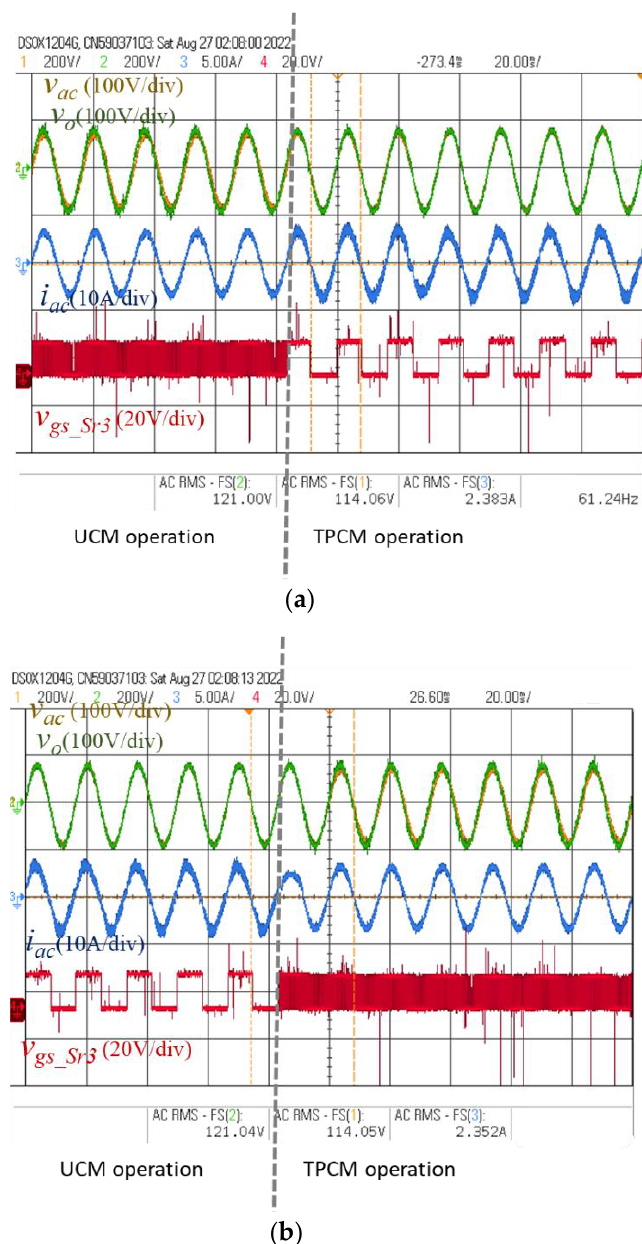
Figure 19. Experimental waveforms of the H-bridge inverter for the grid-connected operation and the standalone operation.